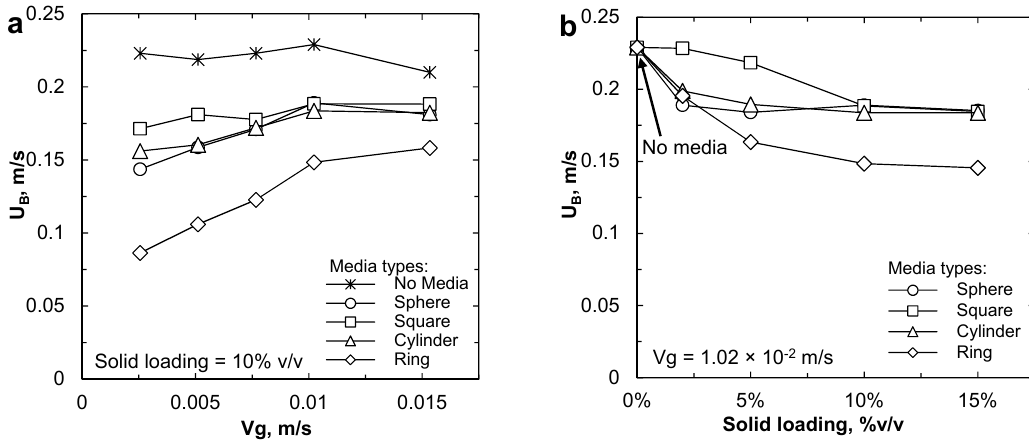
Figure 4. Bubble rising velocity (U B ) in BCR of each solid media type with: ( a ) superficial gas velocity (Vg) and ( b ) solid loading.